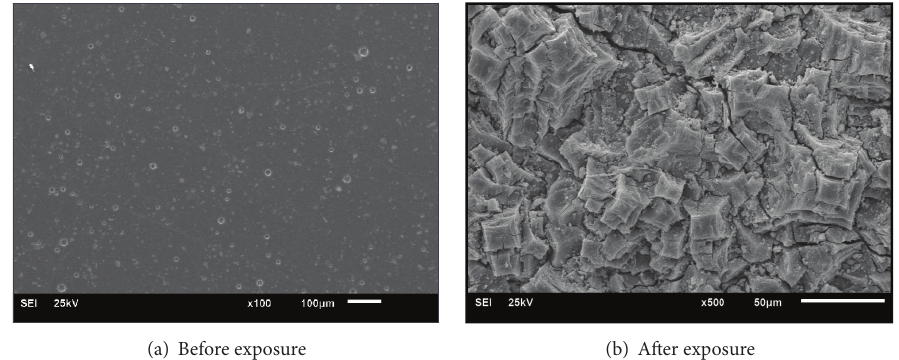
Figure 1: SEM surface morphology of Fusion Bond Epoxy coating: (a) before and (b) after exposure to 5% NaOH solution for 30 days at 93 ∘ C/200 ∘